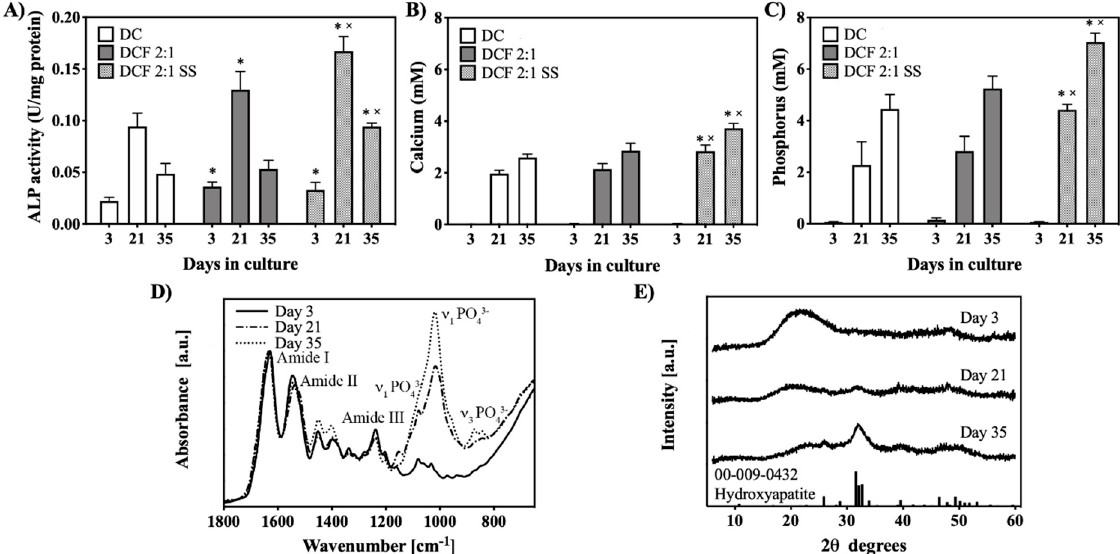
Figure 5. Osteogenic di ff erentiation of MC3T3-E1 cells seeded in gels cultured up to day 35 in osteogenic medium. ( A ) ALP activity in cells seeded in DC, DCF 2:1, and DCF 2:1 SS at days 2, 21, and 35 in culture. ALP activity followed a similar trend in all gels, demonstrating an increase in activity between days 2 and 21, followed by a decrease at day 35. * indicates signi fi cantly ( p < 0.05) higher ALP activity compared to that of DC. × indicates signi fi cantly ( p < 0.05) higher ALP activity compared to that of DCF 2:1. ( B , C ) Quanti fi cation of calcium and phosphorus in medium post-mineralization. ( D ) ATR-FTIR spectra of cell-seeded DCF 2:1 SS gels as a function of culture time in osteogenic medium. There was an increase in the absorption bands related to phosphate and carbonate groups with time in culture. ( E ) XRD di ff ractograms of cell-seeded DCF 2:1 SS gels as a function of culture time in osteogenic medium. The appearance of a peak at 32 2 theta degrees suggested the presence of an apatitic phase at day 35 in culture.